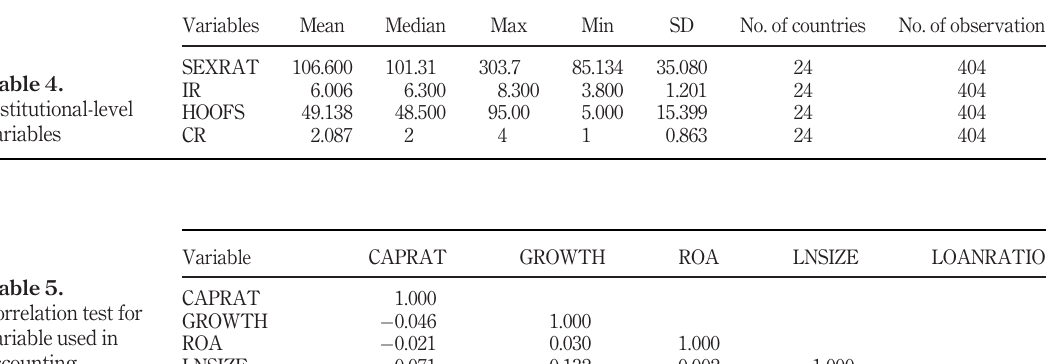
Table 5. Correlation test for variable used in